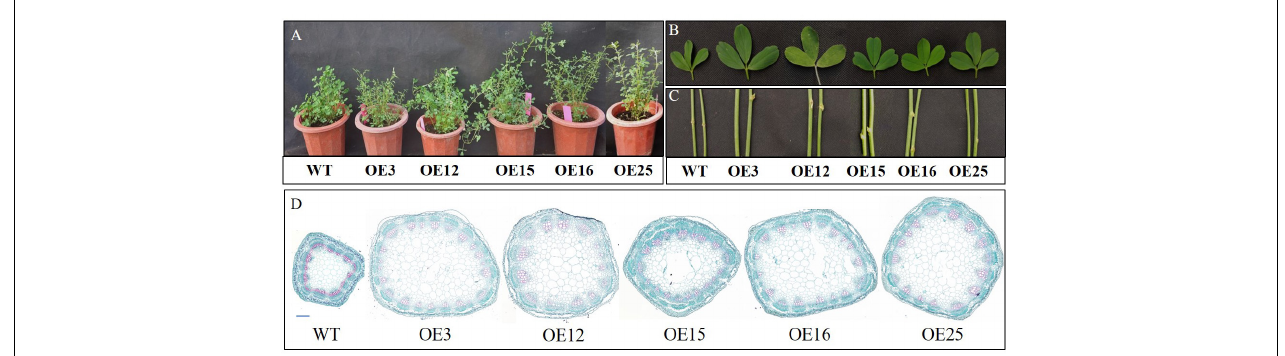
FIGURE 3 | Effects of MsASMT1 overexpression on alfalfa growth and development. (A) Growth situation of WT plants and OE-MsASMT1 transgenic plants after growing in greenhouse for two months; (B,C) the leaf (B) and stem (C) comparison between WT plants and several OE-MsASMT1 transgenic plants, scale bar, 1 cm; (D) Stem cross sections with safranin green staining of WT plants and OE-MsASMT1 transgenic plants, scale bar, 1 mm.